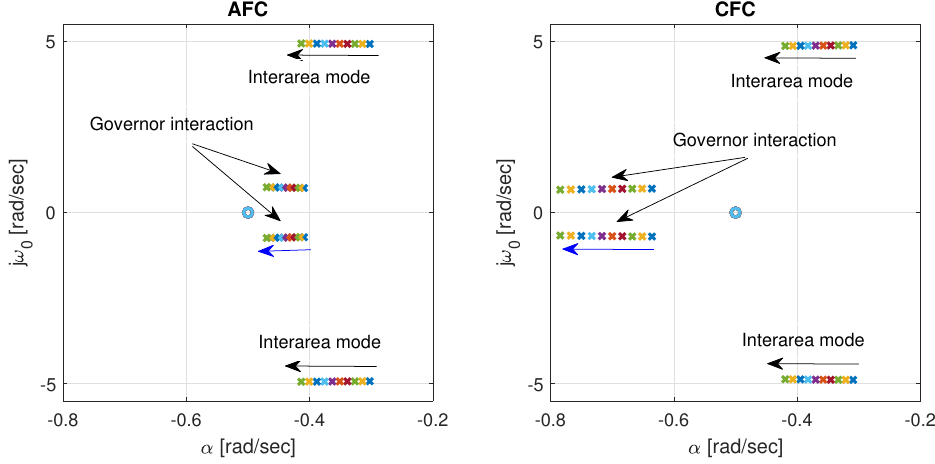
Figure 7. The zeros and poles of the system where k f is increased from 12.5 to 17.5 per-unit. The plots are zoomed in to clearly show the changes of eigenvalues related to interarea mode. ’x’ and ’o’ respectively indicate poles and zeros of the